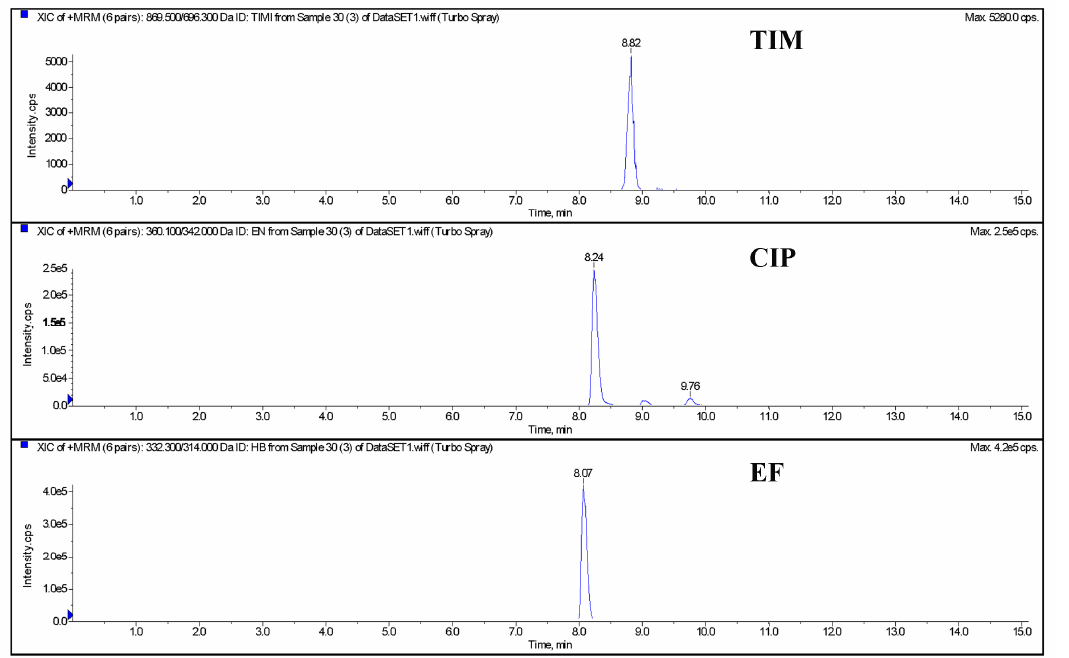
Figure 1. The chromatography of quantitative ions of control blank and spiked egg (TIM, CIP, and EF) by LC-MS/MS. Note: TIM (tilmicosin), EF (enrofloxacin), CIP (ciprofloxacin).